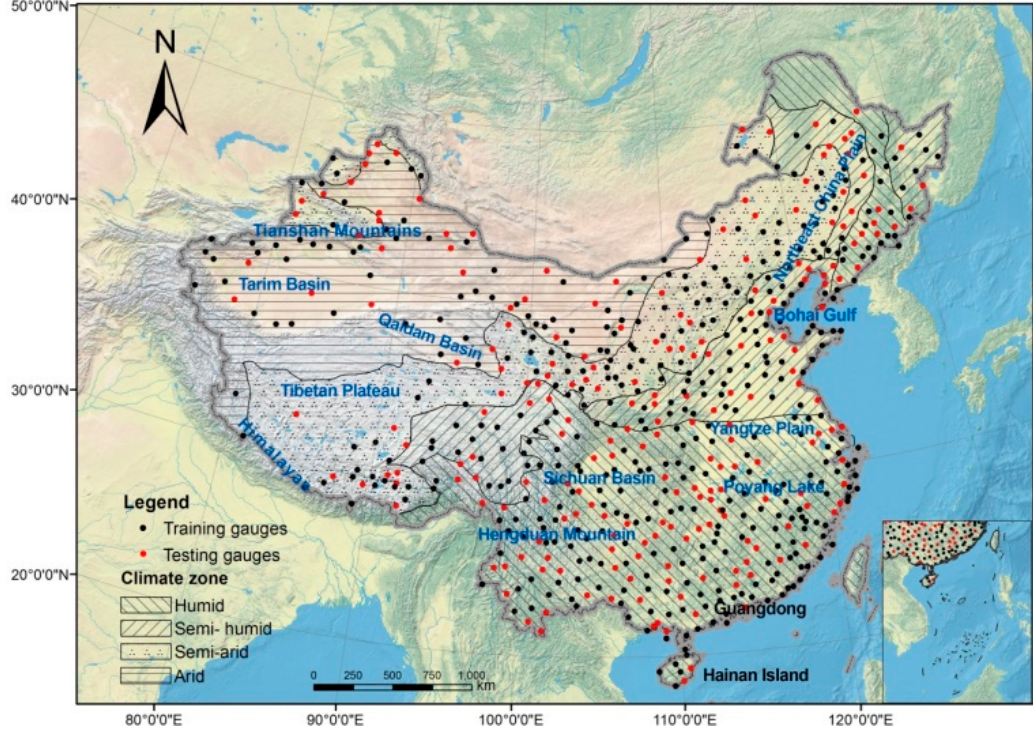
Figure 1. Spatial distribution of rain gauges used in this study and their relation to the climate zones. The black circles show the locations of 433 training rain gauges and the red circles represent the locations of the 217 testing rain gauges used in our study. Table 1. Number of rain gauges in each climate region and each region’s percentage of total number of rain gauge stations across China